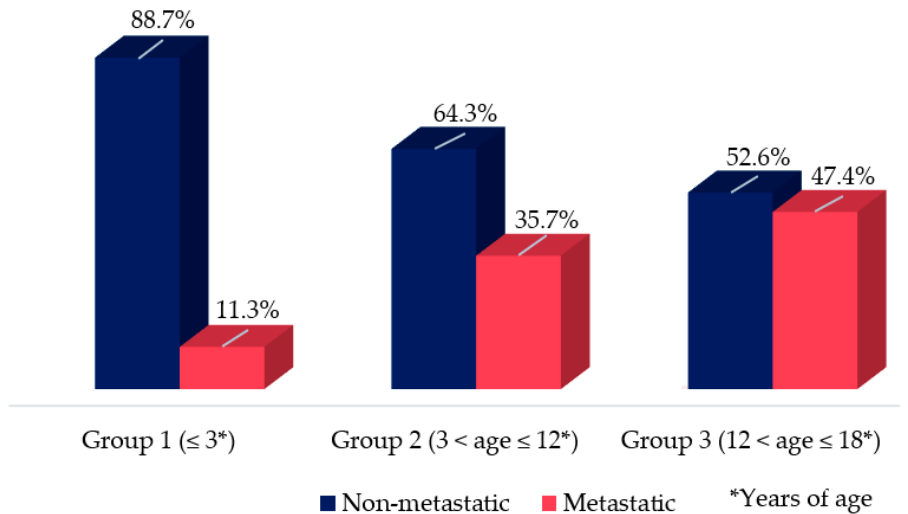
Figure 1. Percentage of metastatic and non-metastatic pediatric patients diagnosed with adrenocortical tumor according to age-groups; group 1: ≤ 3 years of age; group 2: 3 < age ≤ 12 years of age; group 3: 12 < age ≤ 18 years of age. Patient aged > 3 years are more likely to develop a malignant evolution ( p = 0.03; HR: 2.5; CI 95% 1.07–5.8).